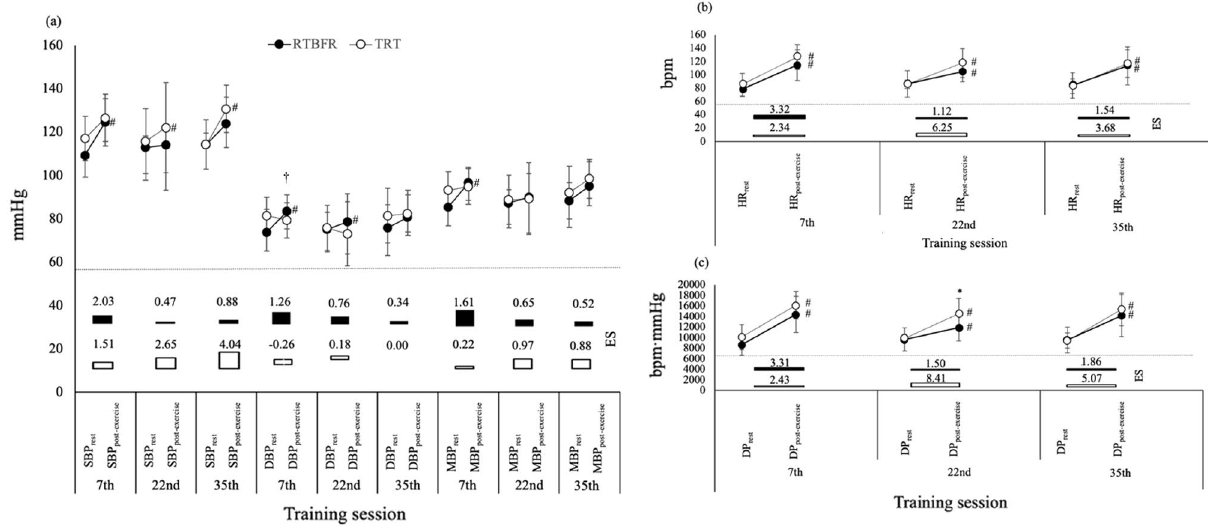
Figure 4. Within and between-group comparison for acute hemodynamic responses (rest versus post-exercise sessions) controlled for antihypertensive treatment. # p < 0.05: Statistically significant difference between rest and immediately post-exercise (within groups comparisons; paired t-test or Wilcoxon test). *p < 0.05: Statistically significant difference between groups (general linear models-GLM with SIDAK post hoc test adjusted for antihypertensive treatment). † p < 0.05: Statistically significant group-by-time interactions. ( a ) Blood pressure; ( b ) heart rate; ( c ): double product. RTBFR: resistance training with blood flow restriction; TRT: traditional resistance training; ES: effect size; SBP: systolic blood pressure; DBP: diastolic blood pressure; MBP: mean blood pressure; HR: heart rate; DP: double product. Obs: acute intra-exercise hemodynamic responses in the middle of the session (intermediate) were not displayed for figure resolution purposes. These values were displayed in